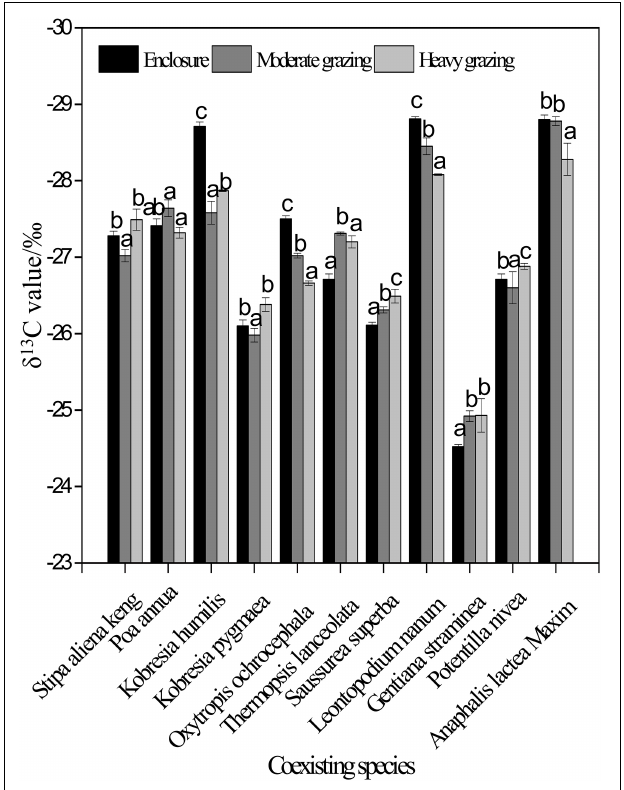
FIGURE 2 | δ 13 C values of coexisting species under different grazing intensities. Different letters under the same level of treatment indicate significant differences ( P < 0.05), and the same letters indicate insignificant